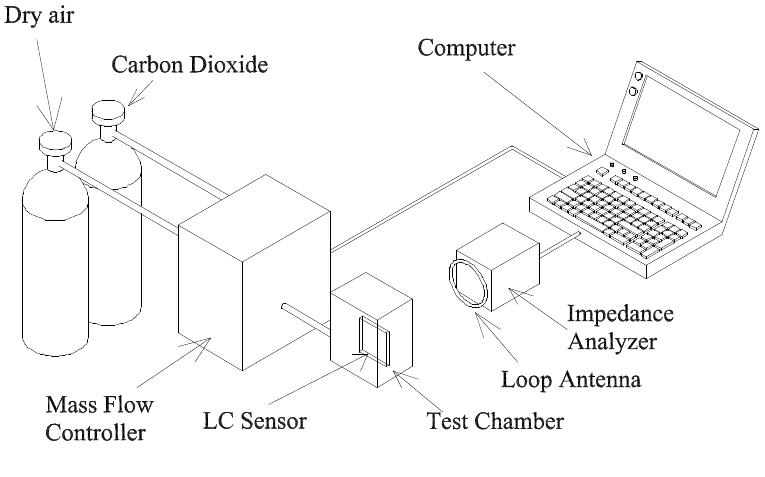
Figure 2. Experimental setup for testing the CO sensor. The sensor is placed inside a sealed 2 Plexiglas chamber, and monitored via a loop antenna. An impedance analyzer is used to measure the impedance spectrum across the terminals of the antenna, and a mass-flow controller is used to control the flow rates of different gasses. A computer controls the devices via the GPIB